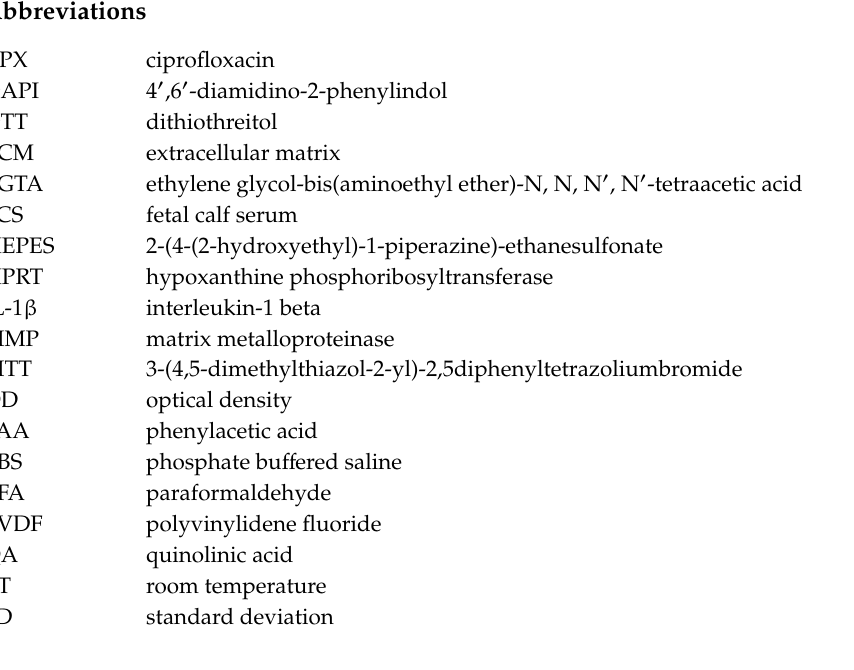
Figure S1. Metabolic activity of tenocytes treated with ciprofloxacin, as measured by alamarBlue assay after 8 h. Figure S2. Morphology of tenocytes treated with CPX, PAA, and QA as shown by light microscopy (100 × magnification). Figure S3. Tenocyte F-actin cytoskeleton after 72 h in response to stimulation with CPX alone and with PAA and QA, alone and in combination with CPX. Figure S4. Expression of tenocyte-associated